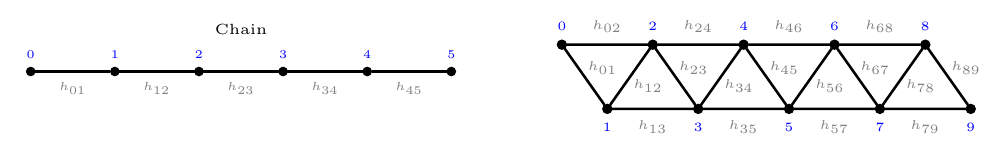
Figure 1: The chain (left) and triangular ladder (right) lattice geometries used in this work.